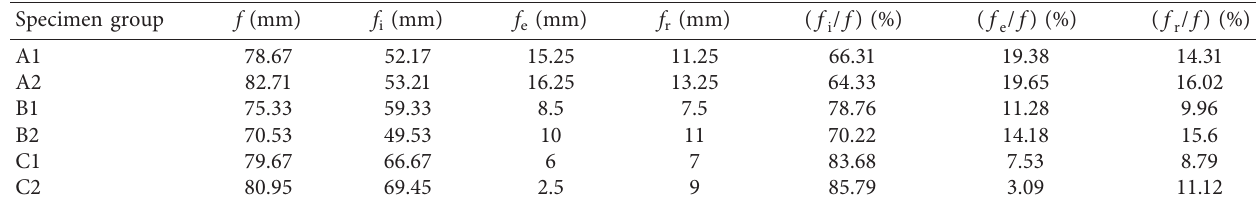
Table 2: Deflection parameter table.